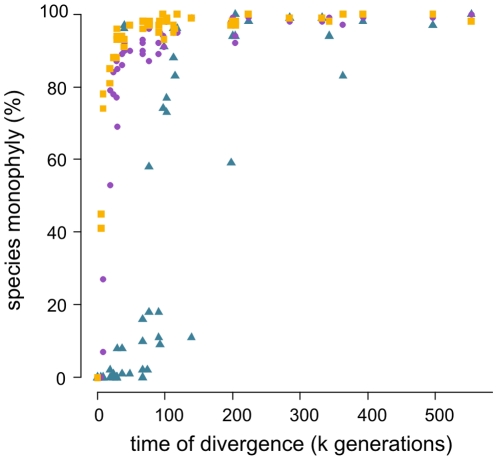
Species monophyly over time of divergence.Scatterplot of percentage species monophyly (N = 100) based on NJ DNA barcode trees for 50 simulated species from the reference data sets (16 individuals per species) plotted against their divergence times. Simulations under coalescence with effective population sizes of 1000 (yellow squares), 10000 (purple dots) and 50000 (blue triangles) individuals.